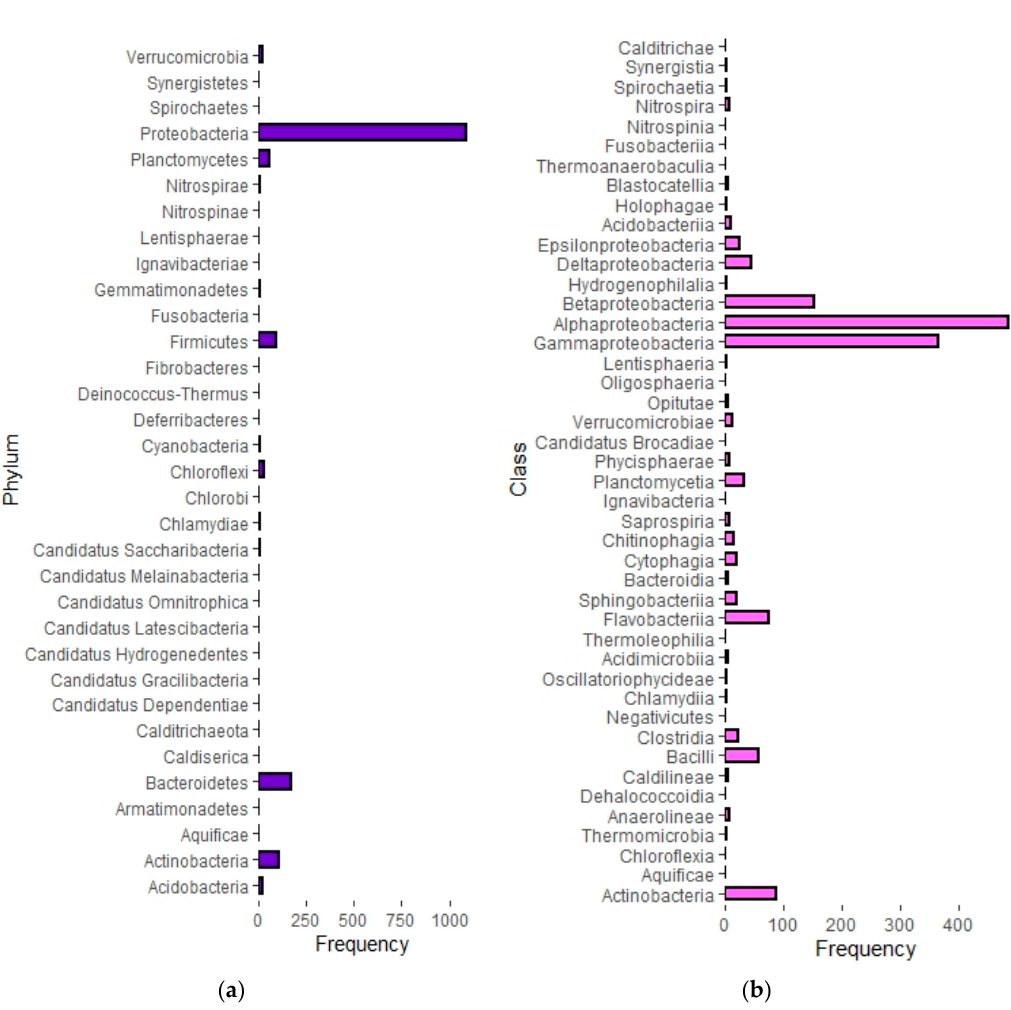
Figure 5 . Phylum-level frequency of organisms identified through semi-systematic review 1 ( a ) Class- Phylum-level frequency of organisms identified through semi-systematic review level frequency of organisms identified through semi-systematic-review. ( b ) The frequency is based on the number of times an organism from a specific phylum or class was identified in the analyzed literature.